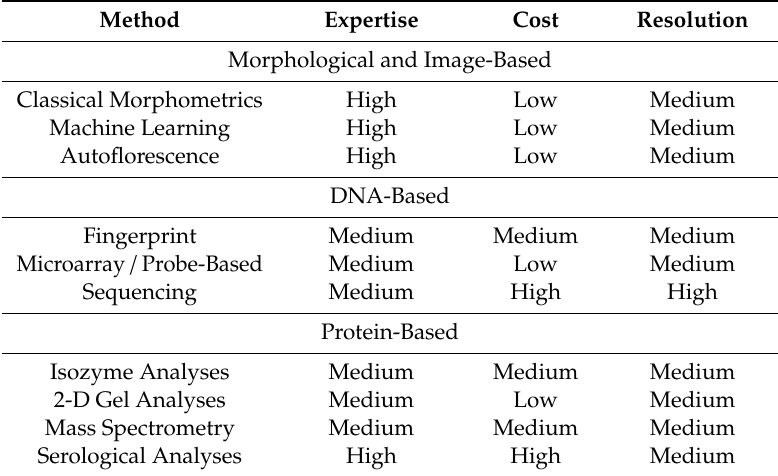
Table 1. Comparison of di ff erent nematode identification